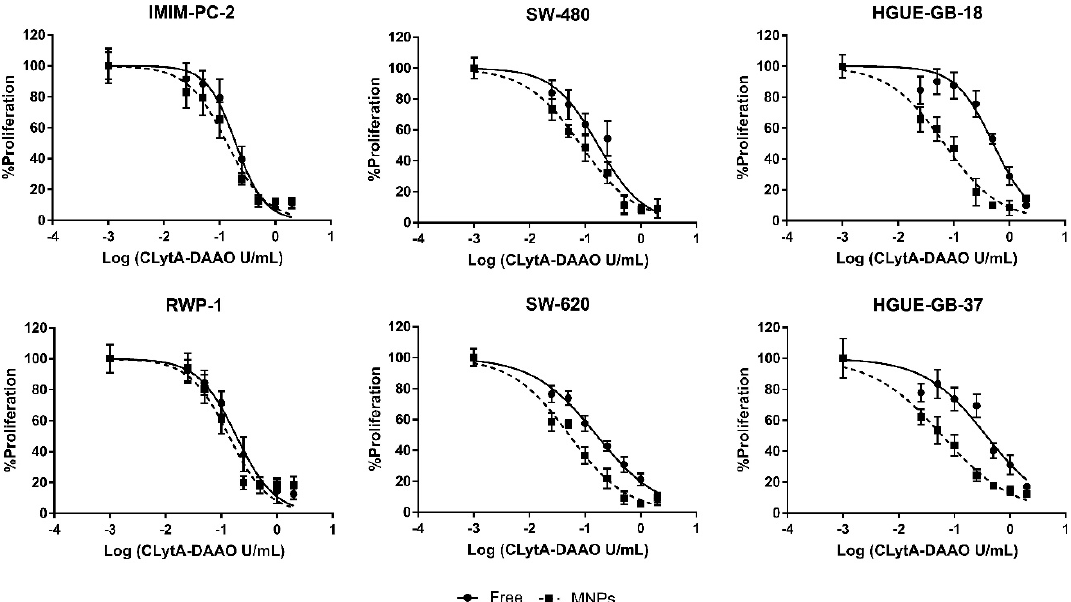
Figure 2. Anti-proliferative effect of CLytA-DAAO, free and bound to MNPs, on pancreatic carcinoma, colorectal carcinoma, and glioblastoma cell lines. Cells were treated with CLytA-DAAO, free or immobilized, in a concentration range between 0.025-2 U/mL and 1 mM D-Ala for 72 h and cell proliferation was determined by MTT assay. Graph shows the proliferation percentage ± SD respect to control untreated versus the logarithm of the concentration ( n ≥ 6). Table 1. Anti-proliferative percentage of 0.025 U/mL and 0.25 U/mL CLytA-DAAO, free or bound to MNPs, with 1 mM D-Ala and IC50 value on pancreatic carcinoma (PC), colorectal carcinoma (CRC), and glioblastoma (GBM) cell lines. Cells were treated with a concentration range between 0.025–2 U/mL CLytA-DAAO and 1 mM D-Ala for 72 h.